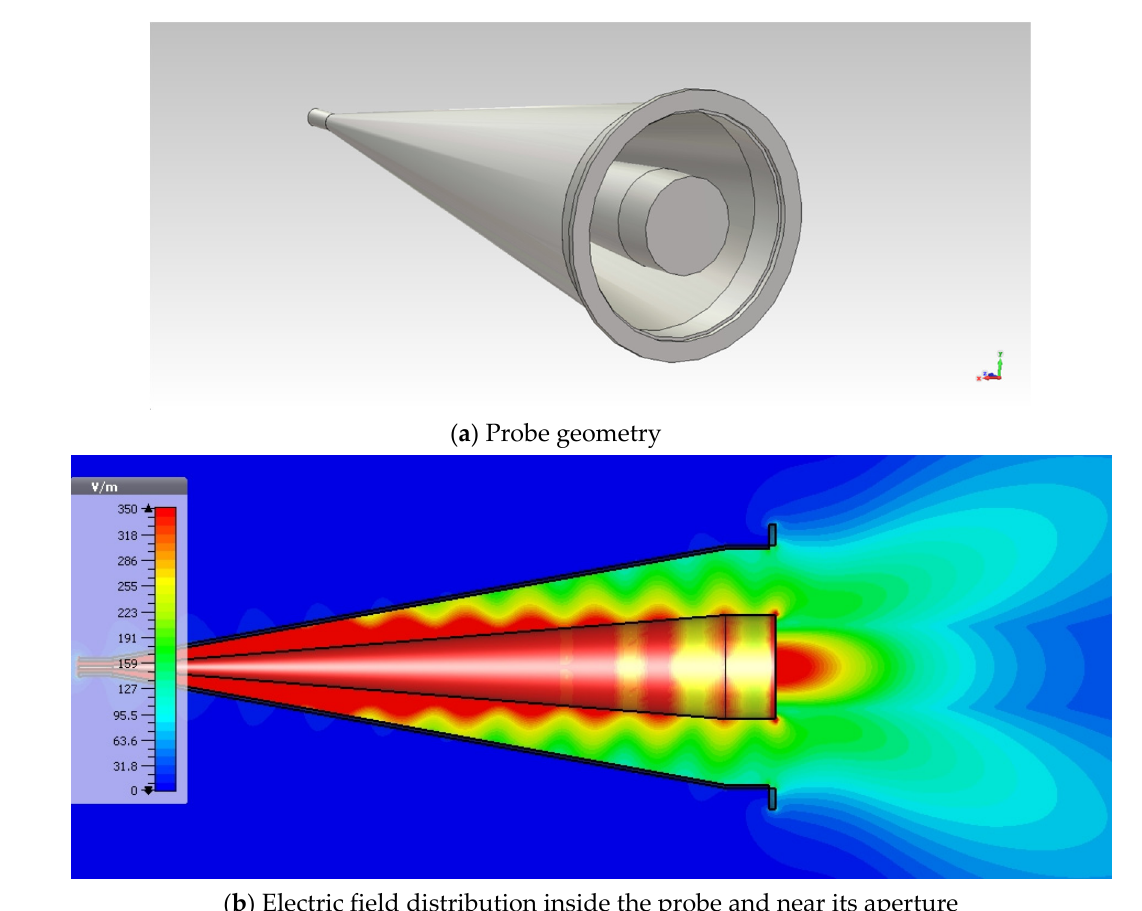
Figure 1. Simulation of the cone probe.